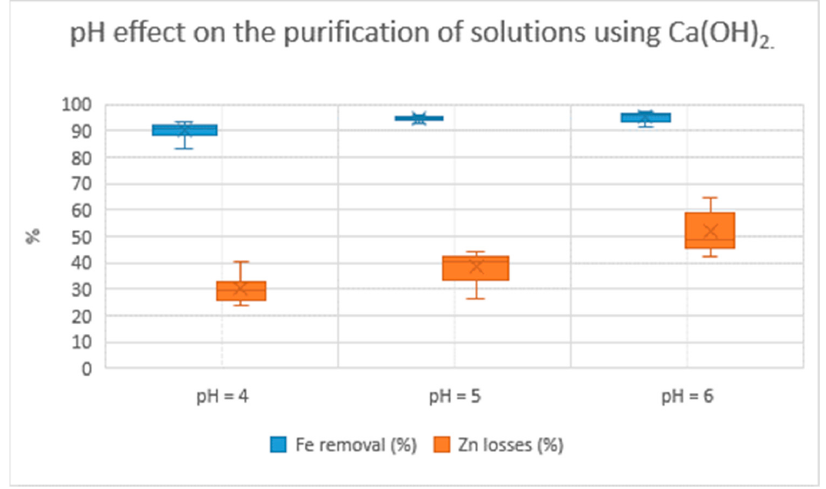
Figure 13. pH effect on the purification of solutions using Ca(OH) 2 . The trends show the effect of pH on the removal of Fe and zinc loss, with a higher incidence of zinc